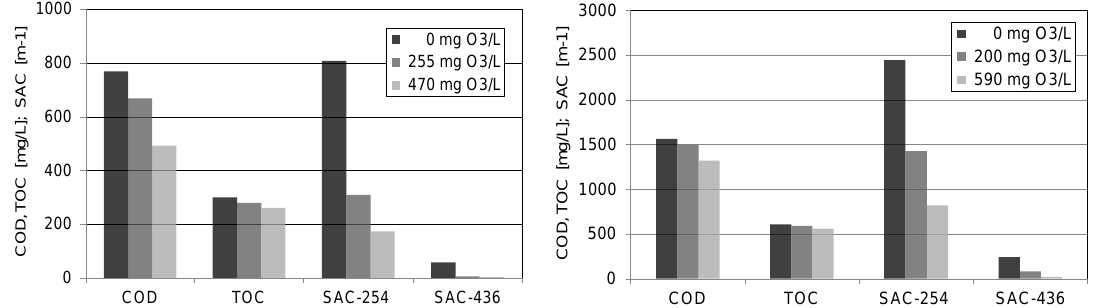
Figure 9. Effect of ozonation on pre-treated HTC spent grains PW ( left ) and fine mulch PW ( right ).